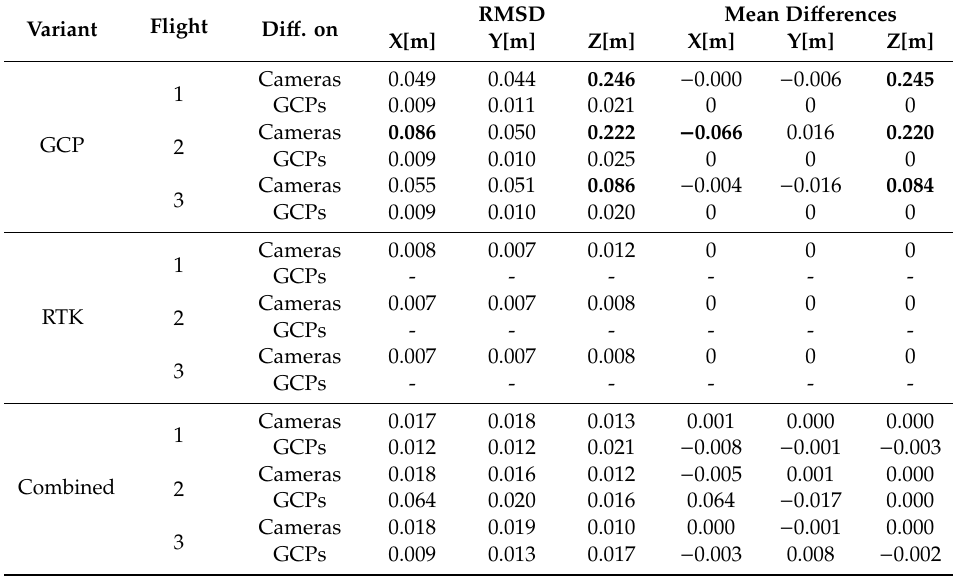
Table 5. Results for the Urban area—RMSDs and the mean di ff erences between the calculated and measured camera / GCP